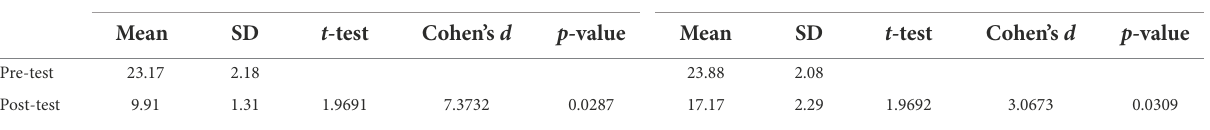
Table 3 Student’s t -test results for the values of the modified K10